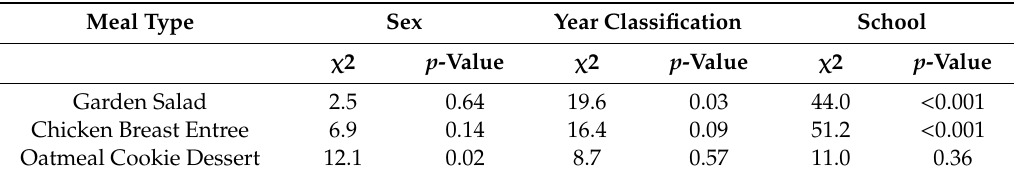
Table 3. Chi-square of study participant characteristics and fat option at meal type in the faith in fat study.